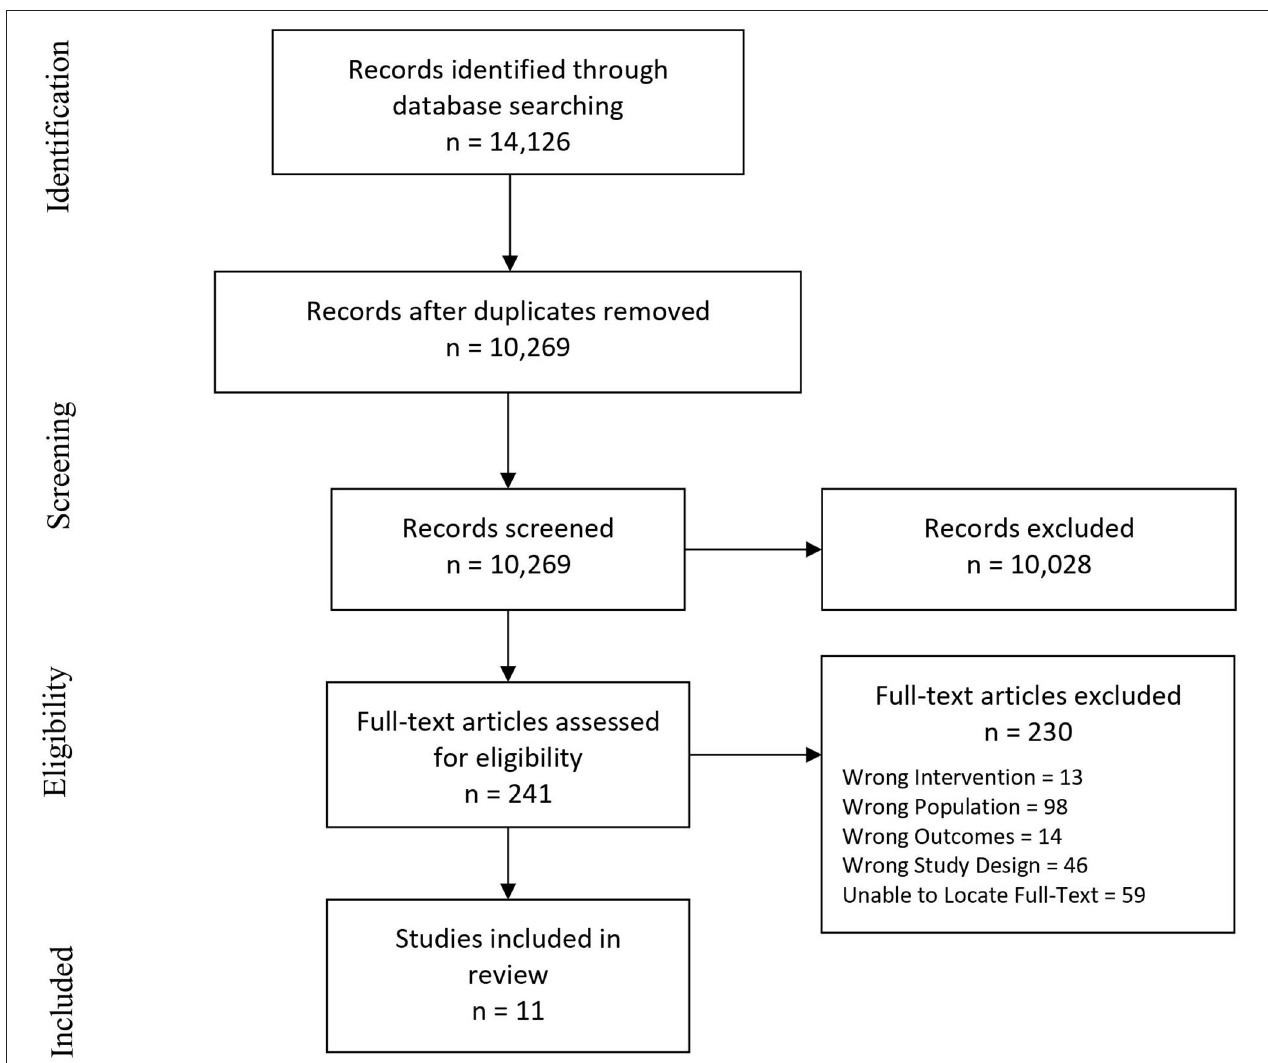
FIGURE 1 | PRISMA flow diagram adapted from Moher, Liberati, Tetzlaff, Altman, & the PRISMA group